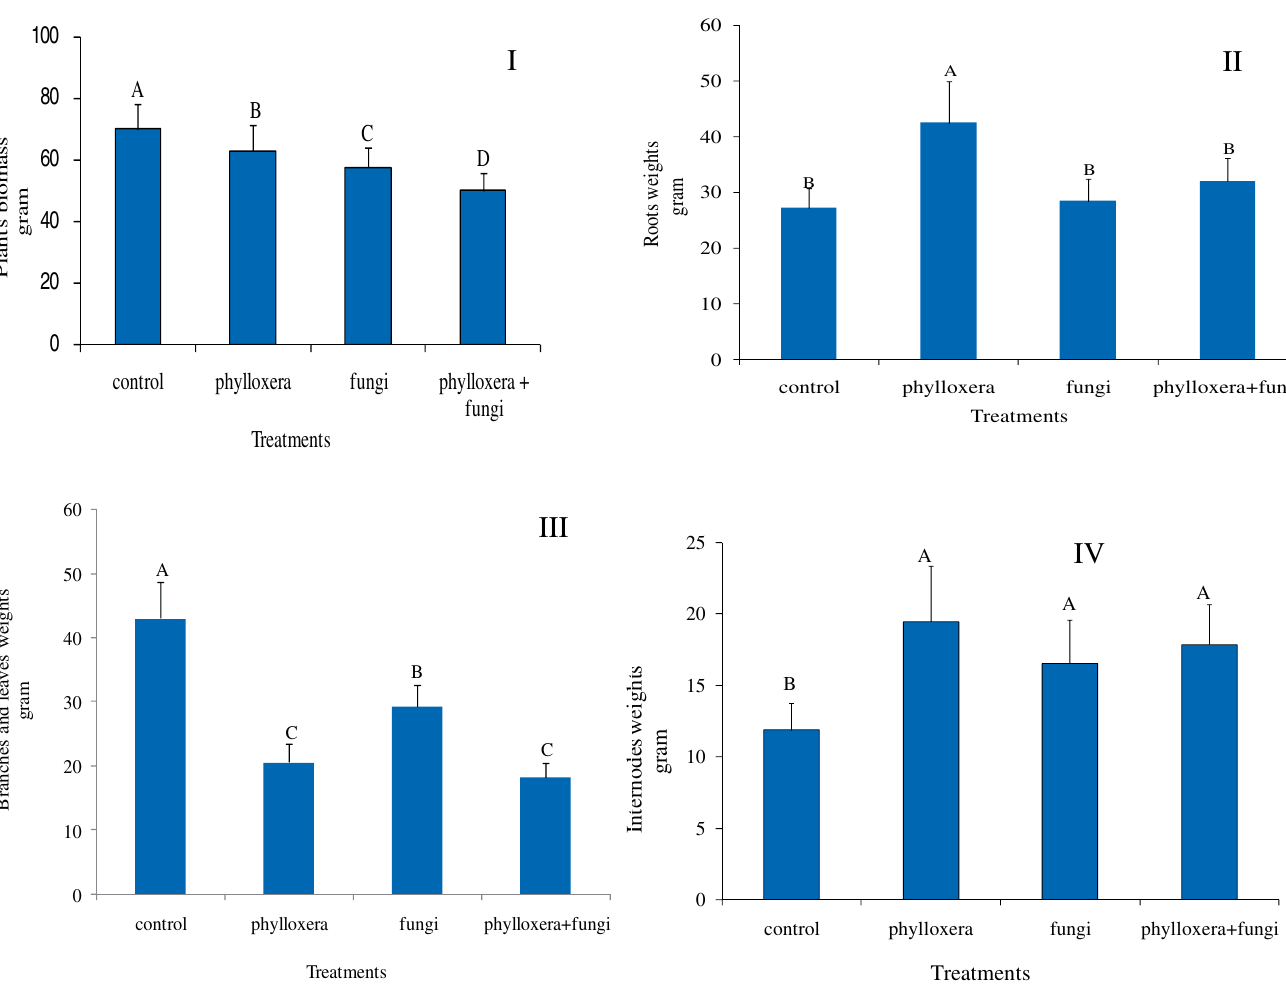
Fig. 1 - Effect of different treatments on plant biomass (I), root (II), branches + leaves weights (III) and internode weights (IV).